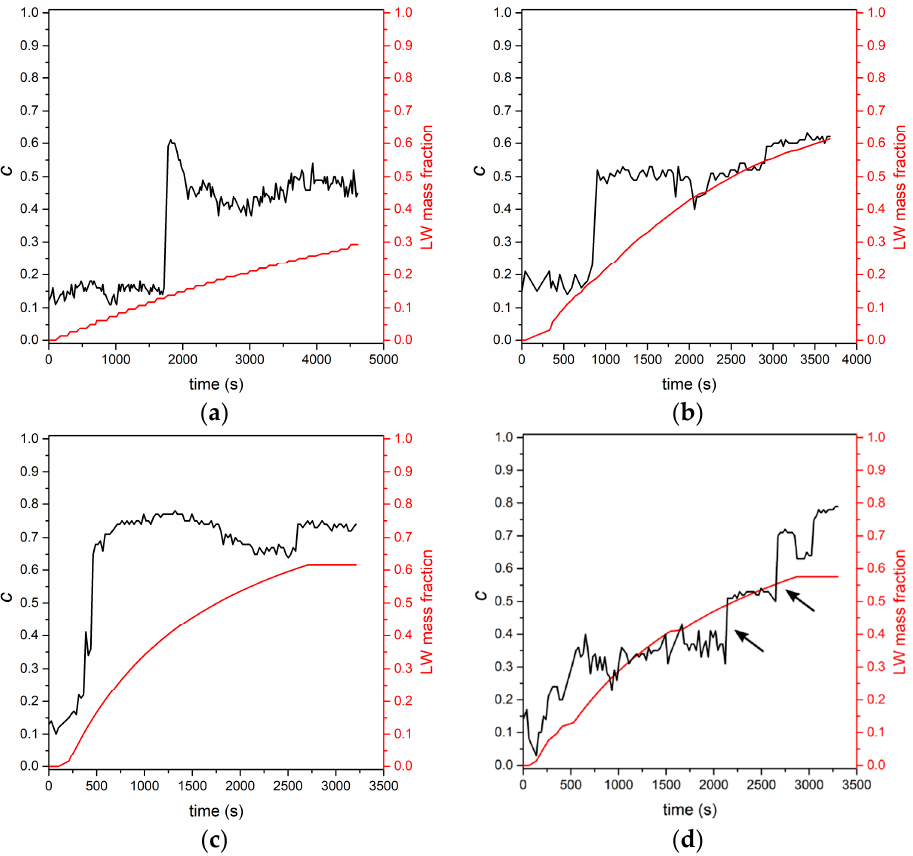
Figure 3. Trend of the c coefficient (black curves and ordinate scale) and liquid water mass fraction (red curves and ordinate scale) for selected combinations of snow kind and degree of liquid water injection. ( a ) NLS, spray; ( b ) NLS, pipette; ( c ) NS, pipette 1st; ( d ) NS, pipette 2nd. See text for details.